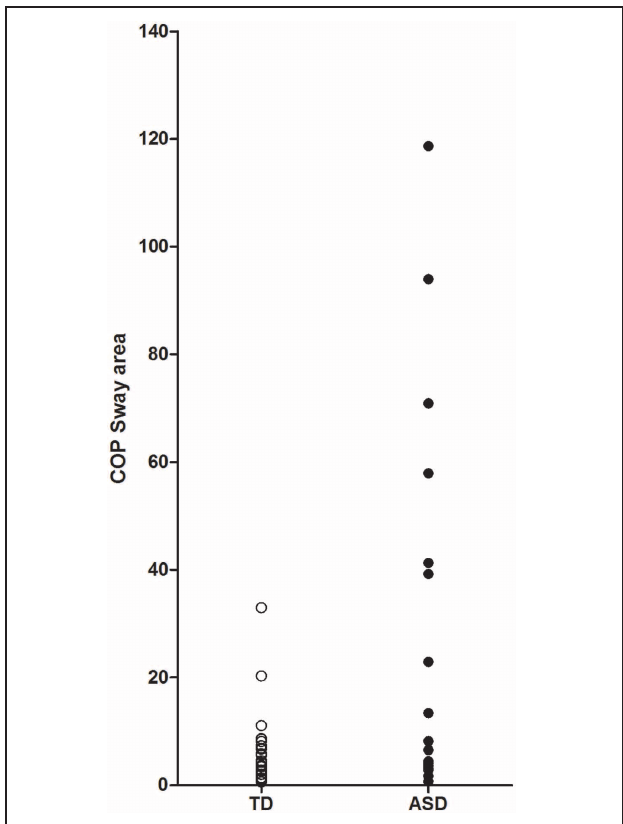
FIGURE 1 | Scatter plot of center of pressure (COP) sway area.